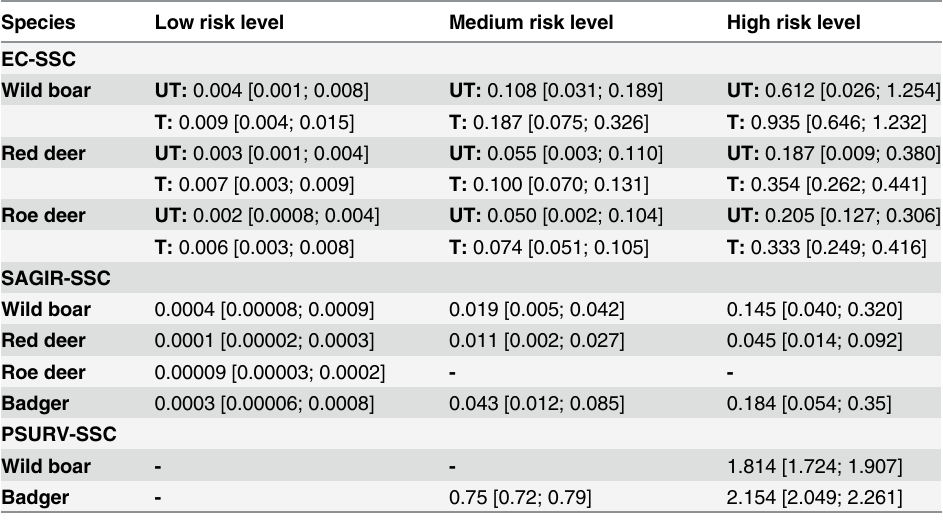
Table 7. Unit sensitivity (CSeU) for each SSC of the Sylvatub system, by species, age class, and geo- graphic risk (percentage, mean [CI 95% ]).